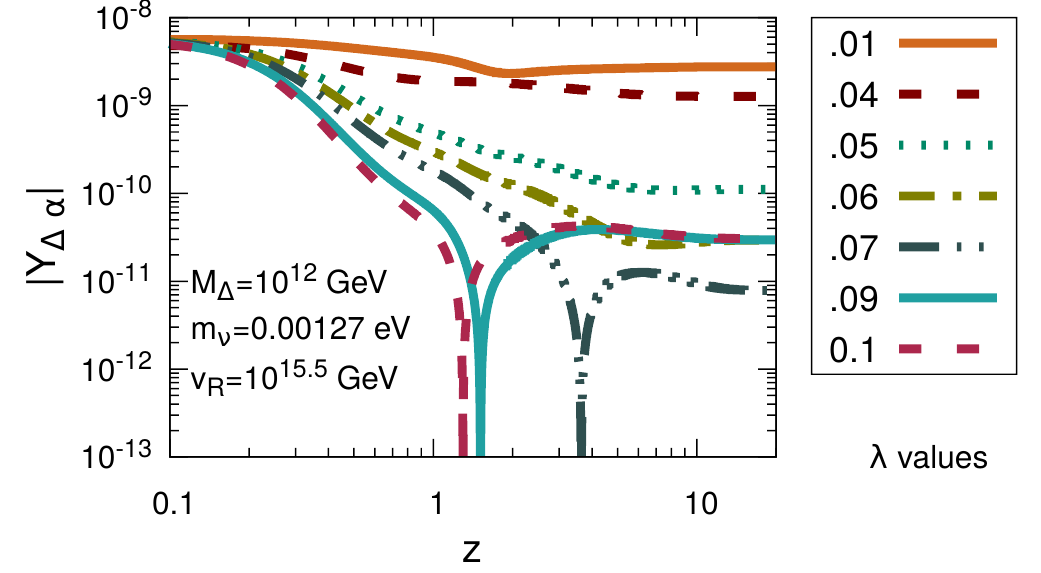
Figure 9 . Total baryon asymmetry vs. z for di(cid:11)erent values of the quartic coupling in the compact spectrum scenario with Dirac neutrino mass matrix determined in the d -quark diagonal basis as described in the